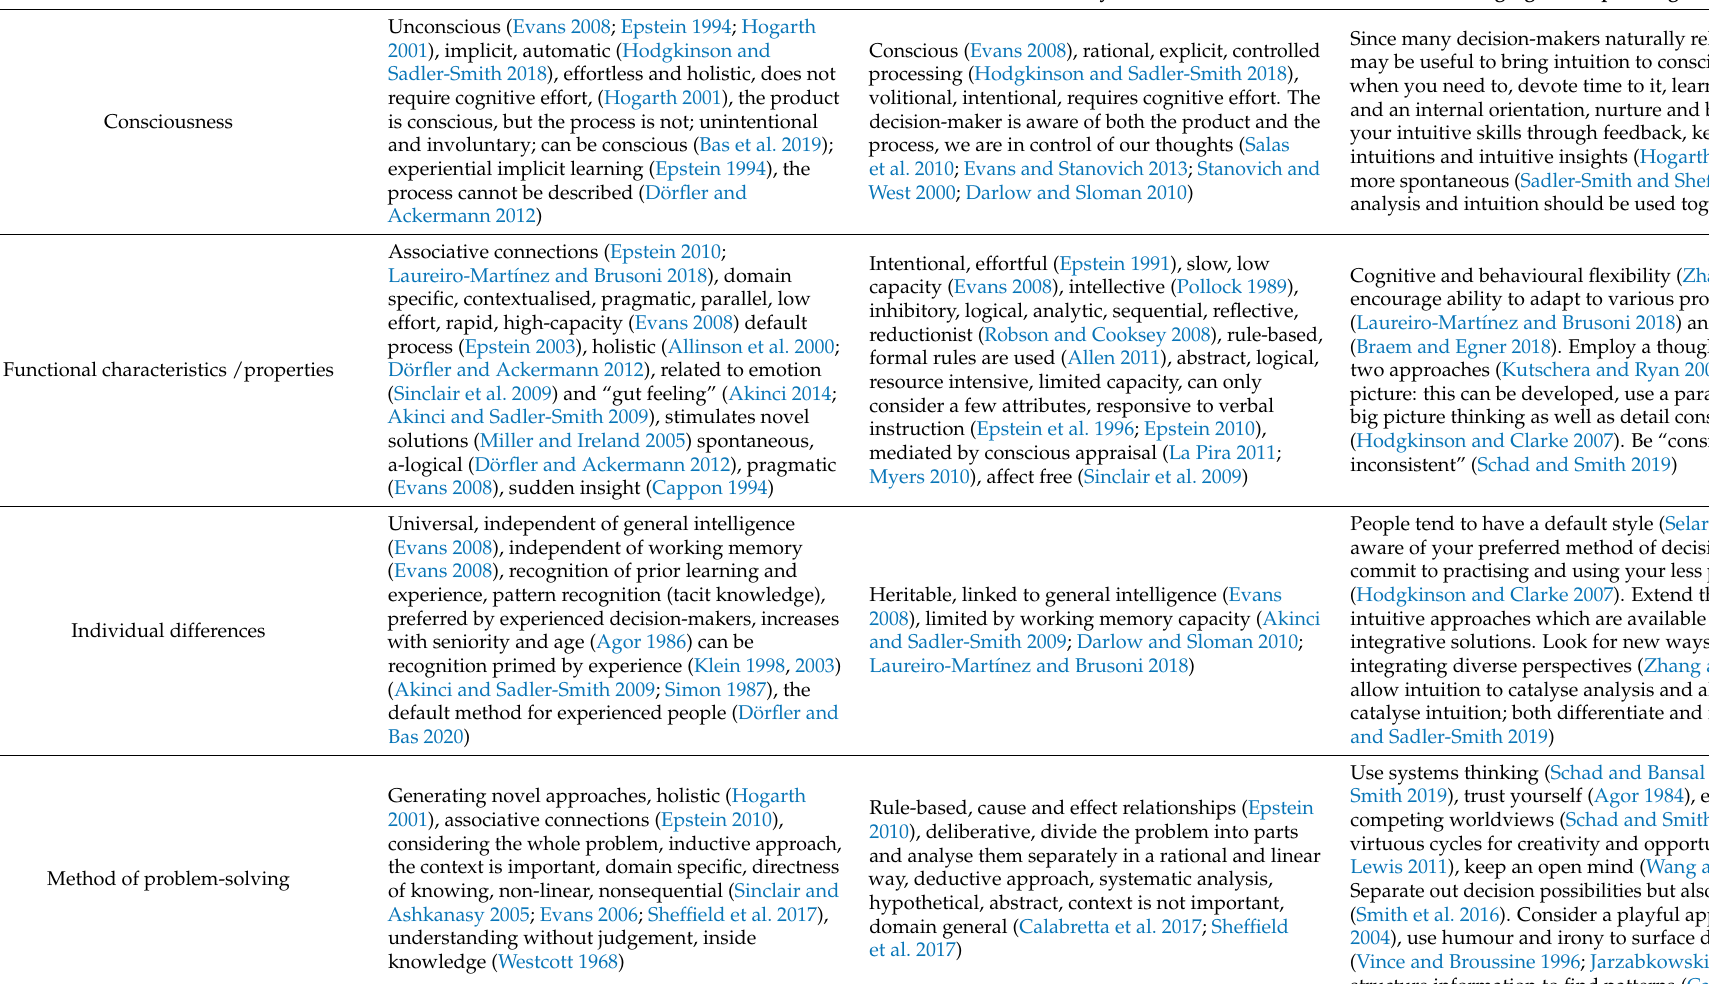
Table 1. Intuition vs. Analysis and the gap through